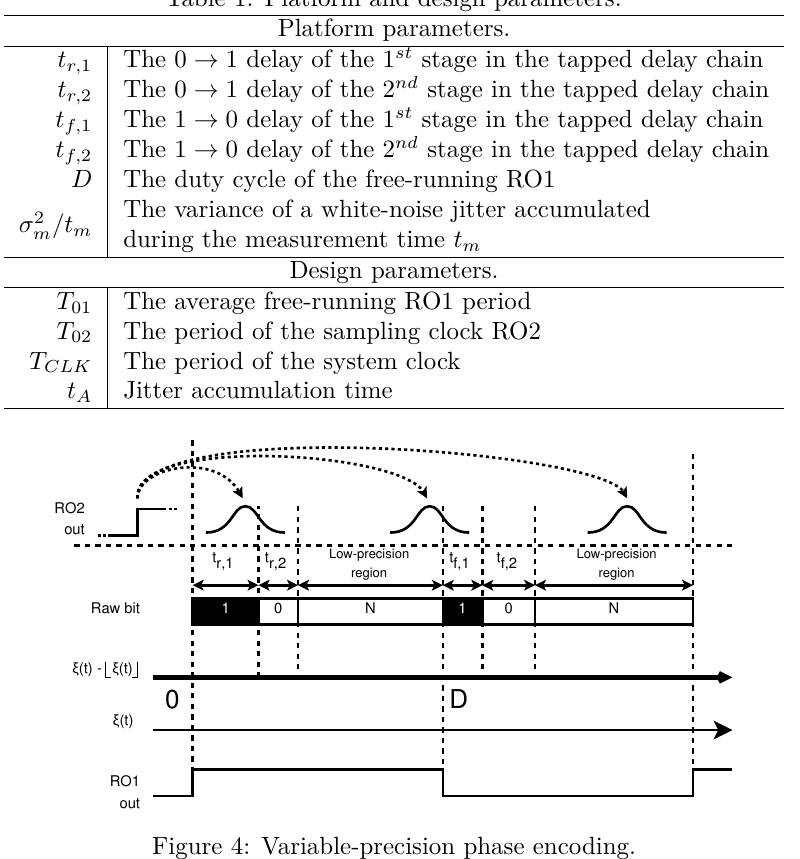
Table 1: Platform and design parameters. Platform parameters.